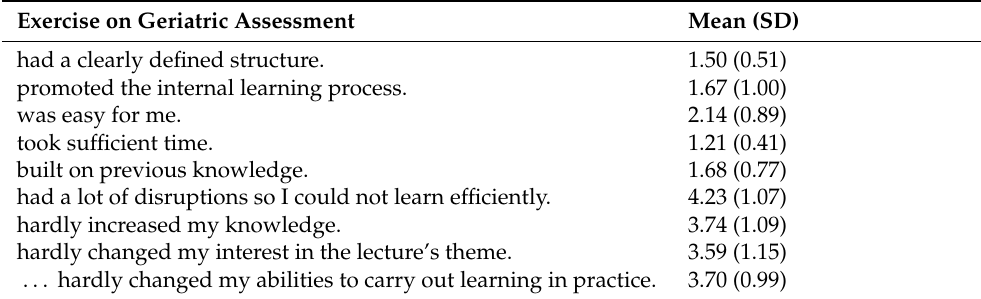
Table 3. Evaluation results of the independent exercise on geriatric